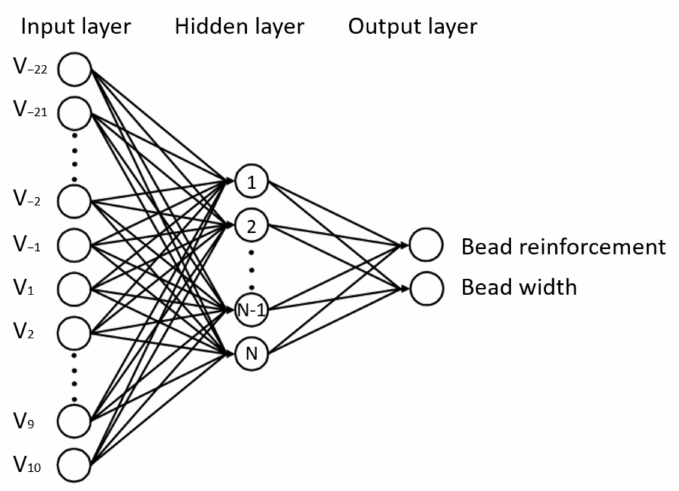
Figure 6. Artificial neural network (ANN) model for bead geometry